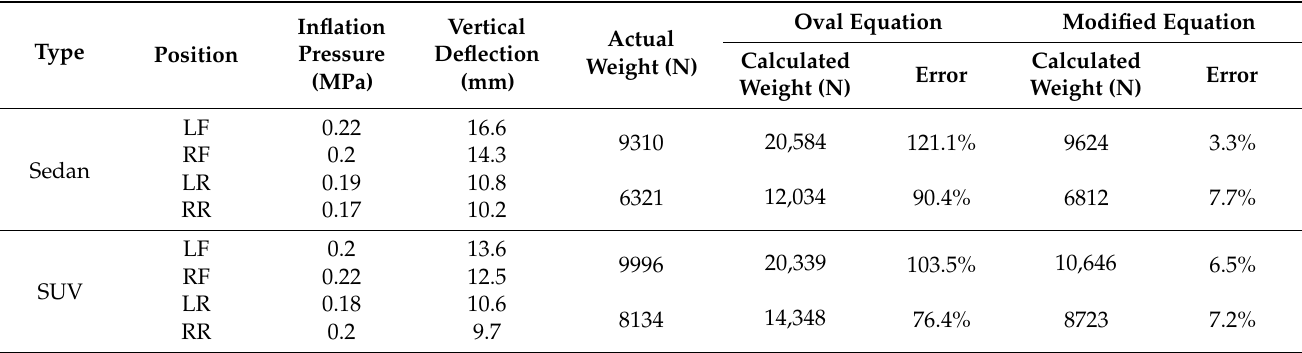
Table 5. Axle weight identification results for passenger cars.